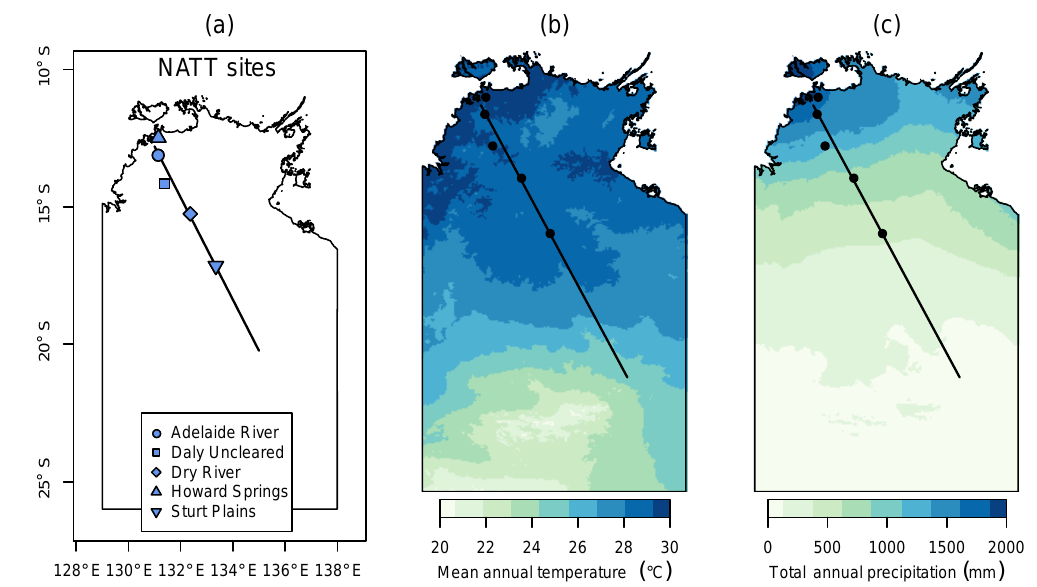
Figure 1. The Northern Territory of Australia and the North Australian Tropical Transect (NATT) showing (a) the flux site locations with an accompanying 30-year (1970 to 2000) expression of the average meteorological conditions for (b) mean annual temperature and (c) total annual precipitation derived from ANUCLIM v6.1 climate surfaces (Hutchinson and Xu,